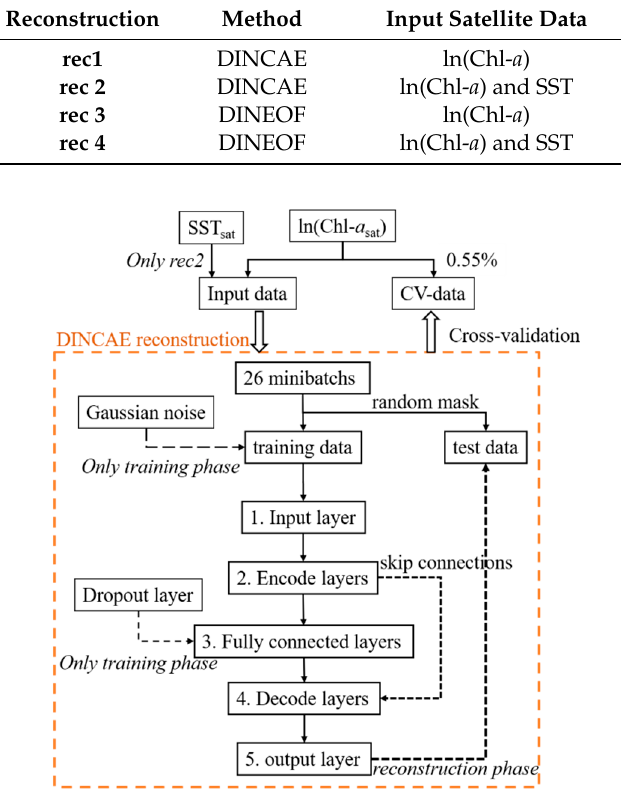
Figure 5. Schematic flowchart for DINCAE reconstruction, where the percentage represents the rate of cross-validation points and 52,112,264 of the total number of sea pixels.